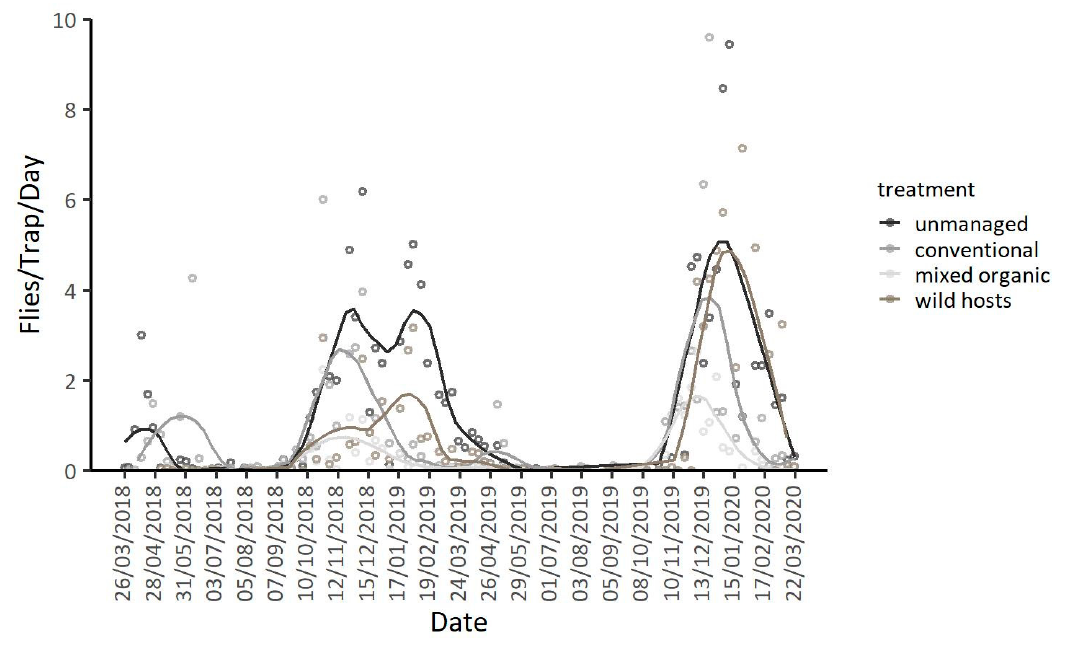
Figure 4. Adult captures per trap per day and LOESS curves (Locally Estimated Scatterplot Smoothing curves) for unmanaged and conventional cherry trees, an organic mixed orchard and wild vegetation in Lehonia from 26 March 2018 to 22 March 2020.